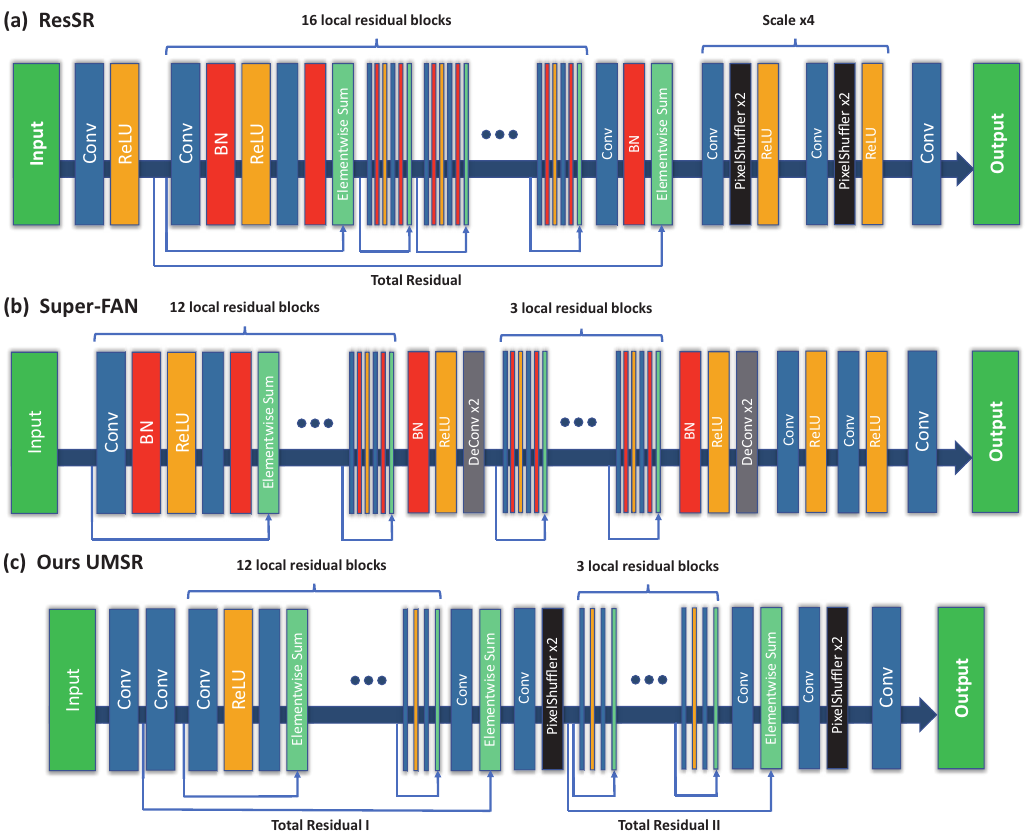
Figure 3. The architectures of ResSR, Super-FAN, and our UMGSR. ( a ) ResSR; ( b ) Super-FAN; ( c ) Ours